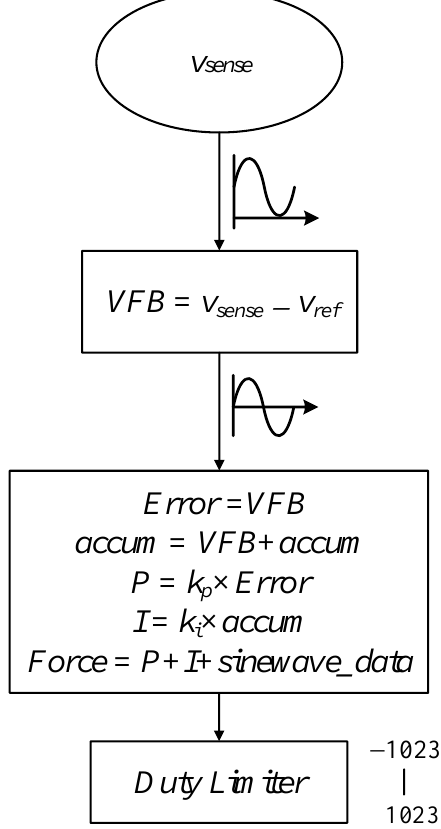
Figure 13. Control flow